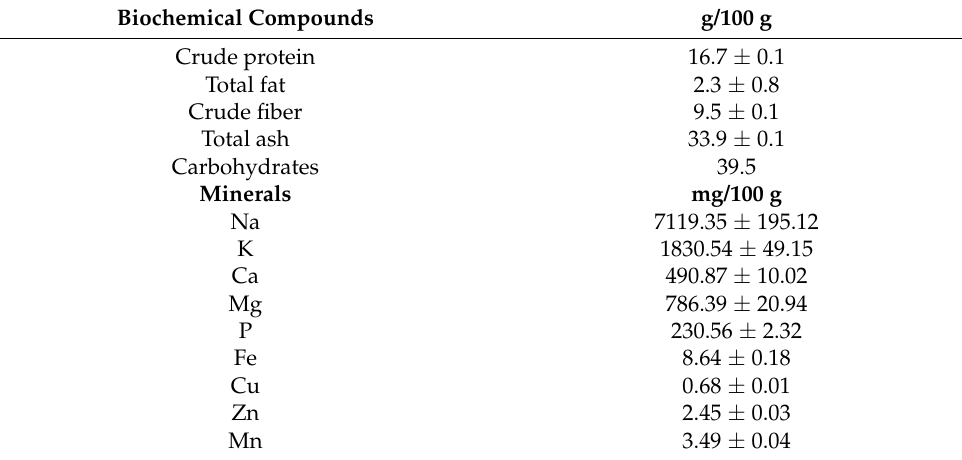
Figure 2. Dried powder of Sarcocornia perennis . Table 1. Proximate biochemical composition (g/100 g) and mineral composition (mg/100 g) of dried S. perennis (powder) [17,22].